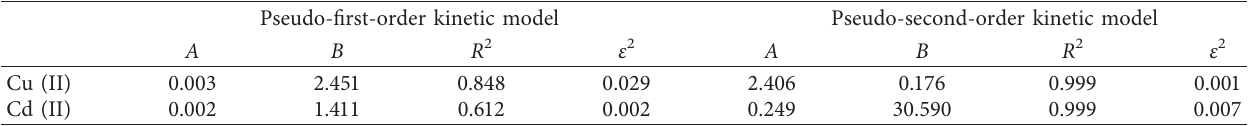
Table 4: Isothermal parameters of adsorption of Cu (II) and Cd (II) by SACL at different temperatures. Metal ion